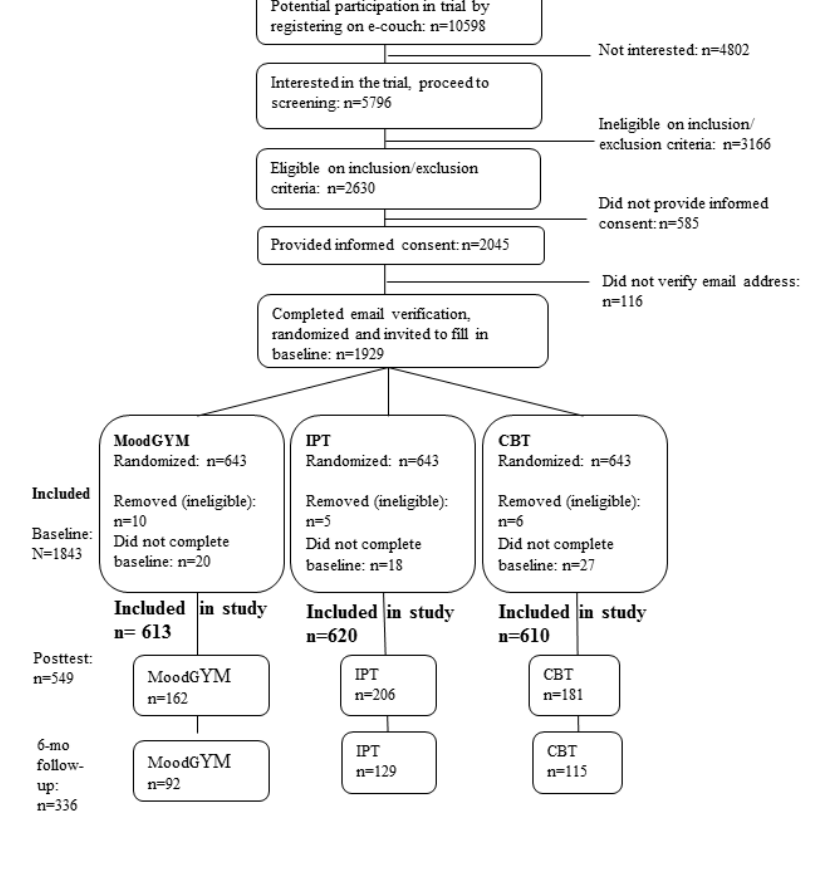
Figure 5. Flowchart of